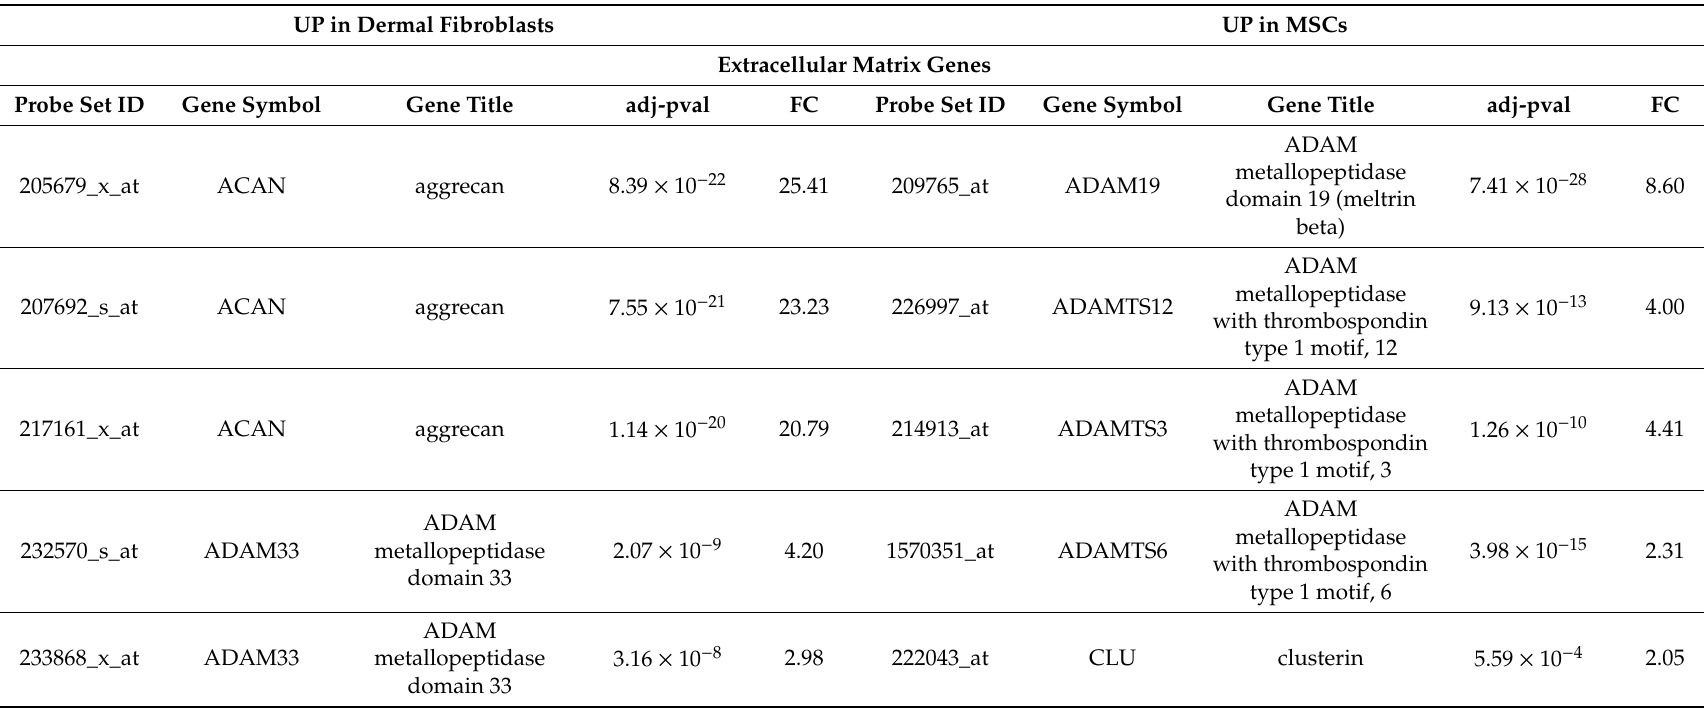
Table 4. Transcripts related to the tissue skeleton, in which di ff erential expressions distinguish the “fibroblast” and mesenchymal stem cell or “MSC” groups. This transcript list was extracted from microarray data using fold-change > 2 and p < 0.05 as inclusion parameters. The transcript signature with predominant expression in the “fibroblast” group concerned 424 probe sets corresponding to transcripts directly involved in the tissue skeleton structure, comprising 145 transcripts related to ECM, 63 focal adhesion point transcripts, 68 cytoskeleton transcripts, 4 LINC complex transcripts, and 12 nucleoskeleton transcripts. The transcript signature with predominant expression in the “MSC” group concerned 241 probe sets corresponding to transcripts directly involved in the tissue skeleton structure, comprising 53 transcripts related to ECM, 63 focal adhesion point transcripts, 52 cytoskeleton transcripts, 2 LINC complex transcripts, and 7 nucleoskeleton transcripts. In addition, transcripts encoding soluble factors were found in both signatures, respectively 132 and 79 for the “fibroblast” and “MSC”